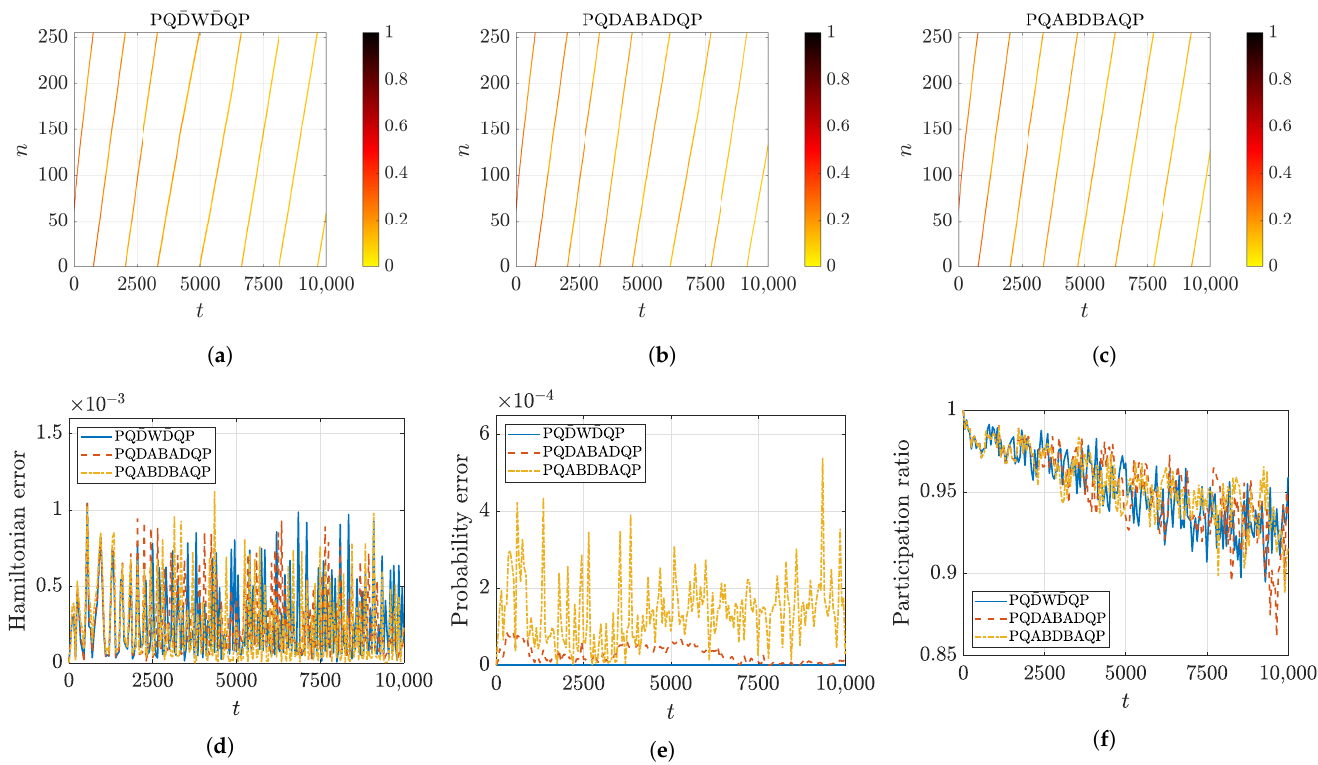
Figure 7. Simulation of charge transfer by a mobile discrete breather with three splitting methods: PQ ¯DW ¯DQP, PQDABADQP, and PQABDBAQP. The solutions are initiated with patterns (100) and (101), where γ = 0.6. Other parameter values: h = 0.01, N = 254 and T end = 10 4 . Top ( a – c ): contours of the charge probability P n . Bottom: ( d ) relative error of the Hamiltonian (42) at each time step; ( e ) relative error of the total charge probability (16) at each time step; ( f ) participation ratio value at each time